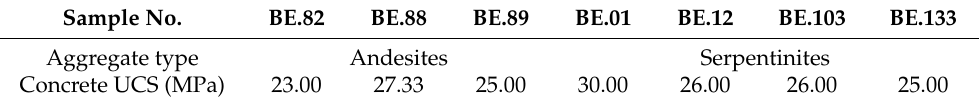
Table 3. Compressive strength of concrete specimens prepared with serpentinites and andesites